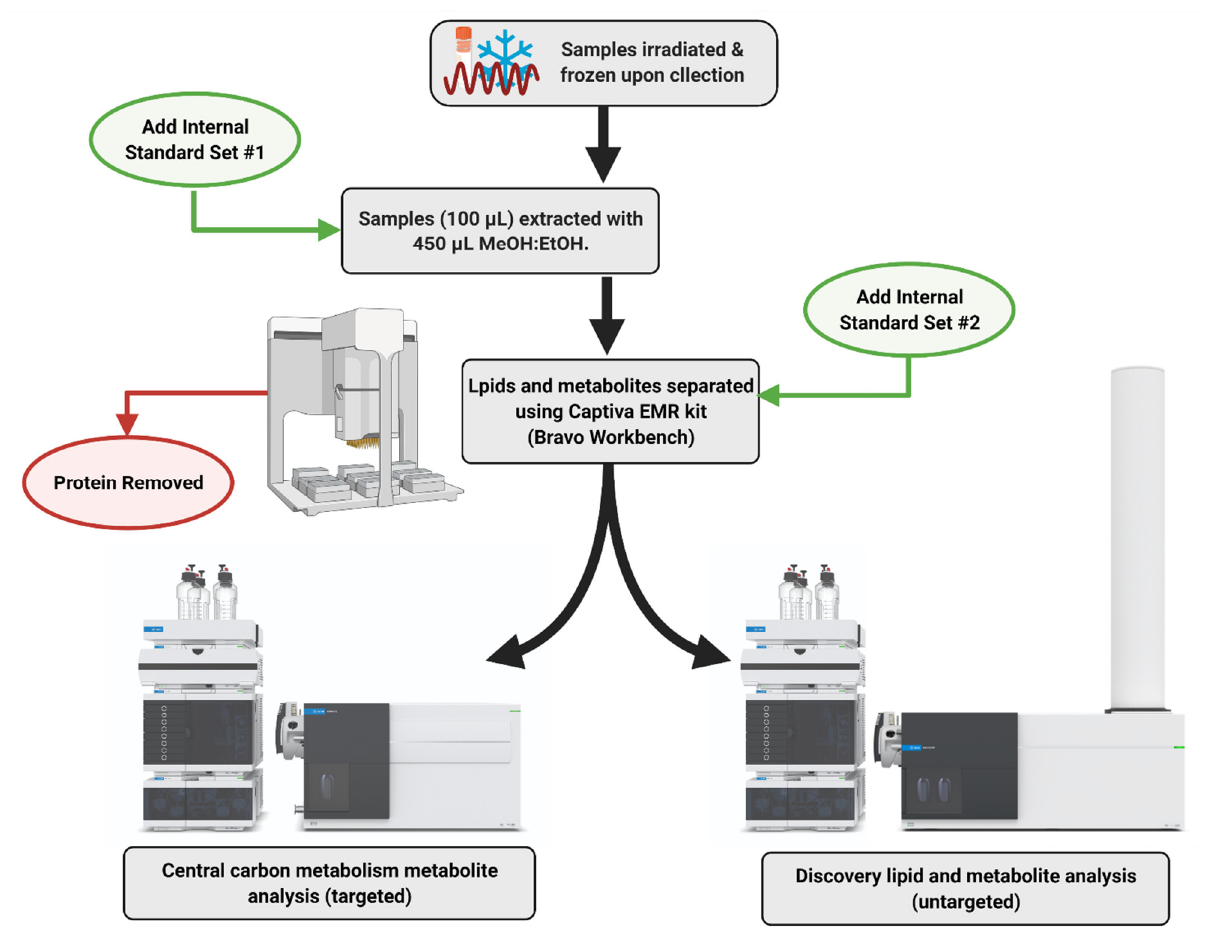
Figure 11. General overview of the sample extraction and analytical workflow of non-invasive samples collected from SARS-CoV-2 challenged ferrets.